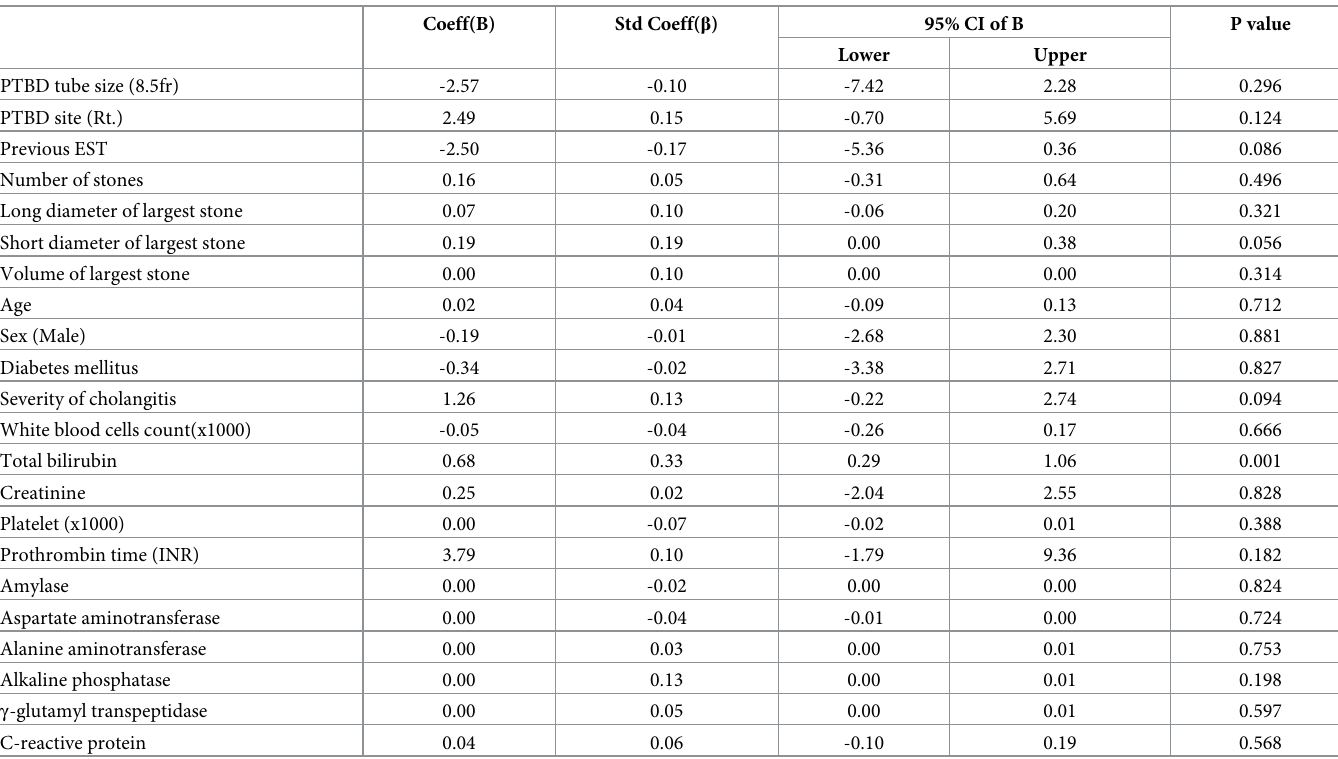
Table 3. Univariate regression analysis of predictive factors for PTBD